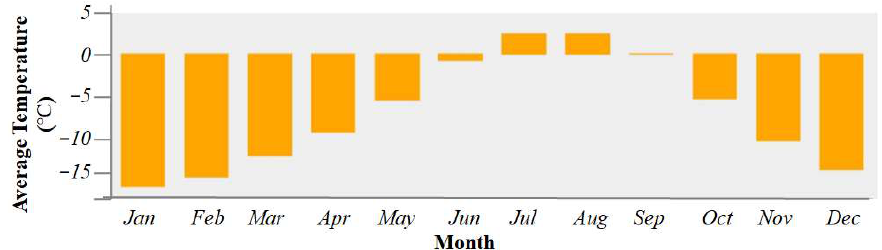
Figure 3. Monthly average temperature variation pattern of the location.